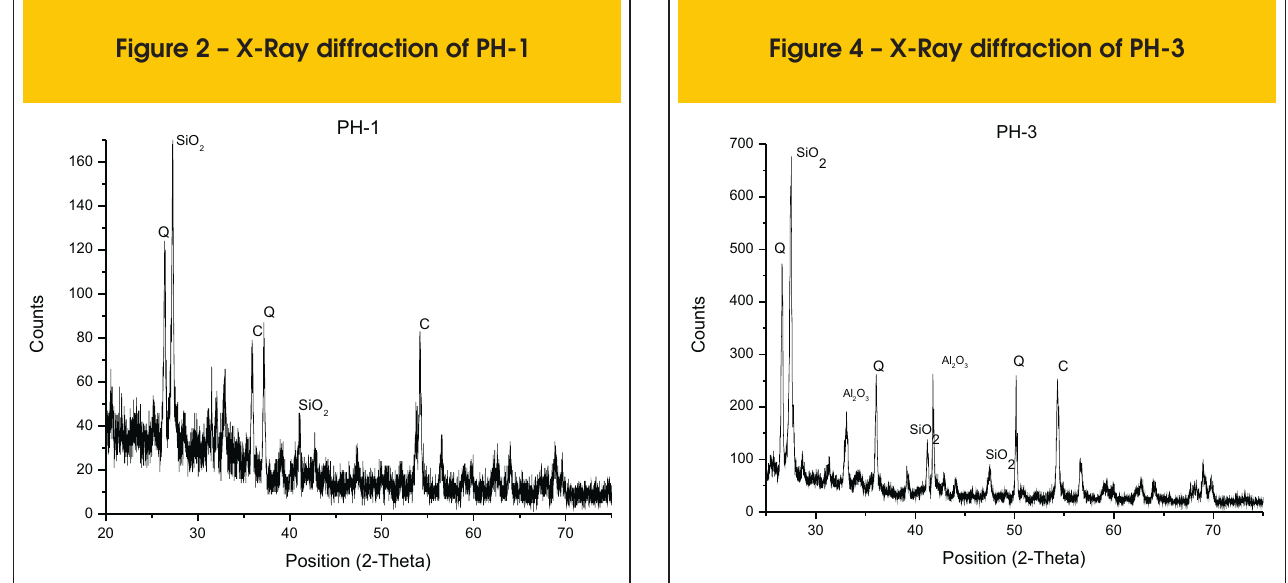
Figure 2 – X-Ray diffraction of PH-1